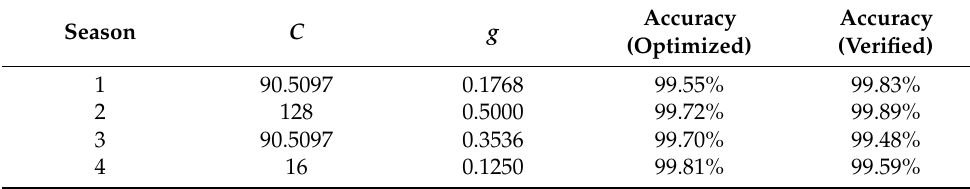
Table 3. SVM parameter optimization and verification results of each season.